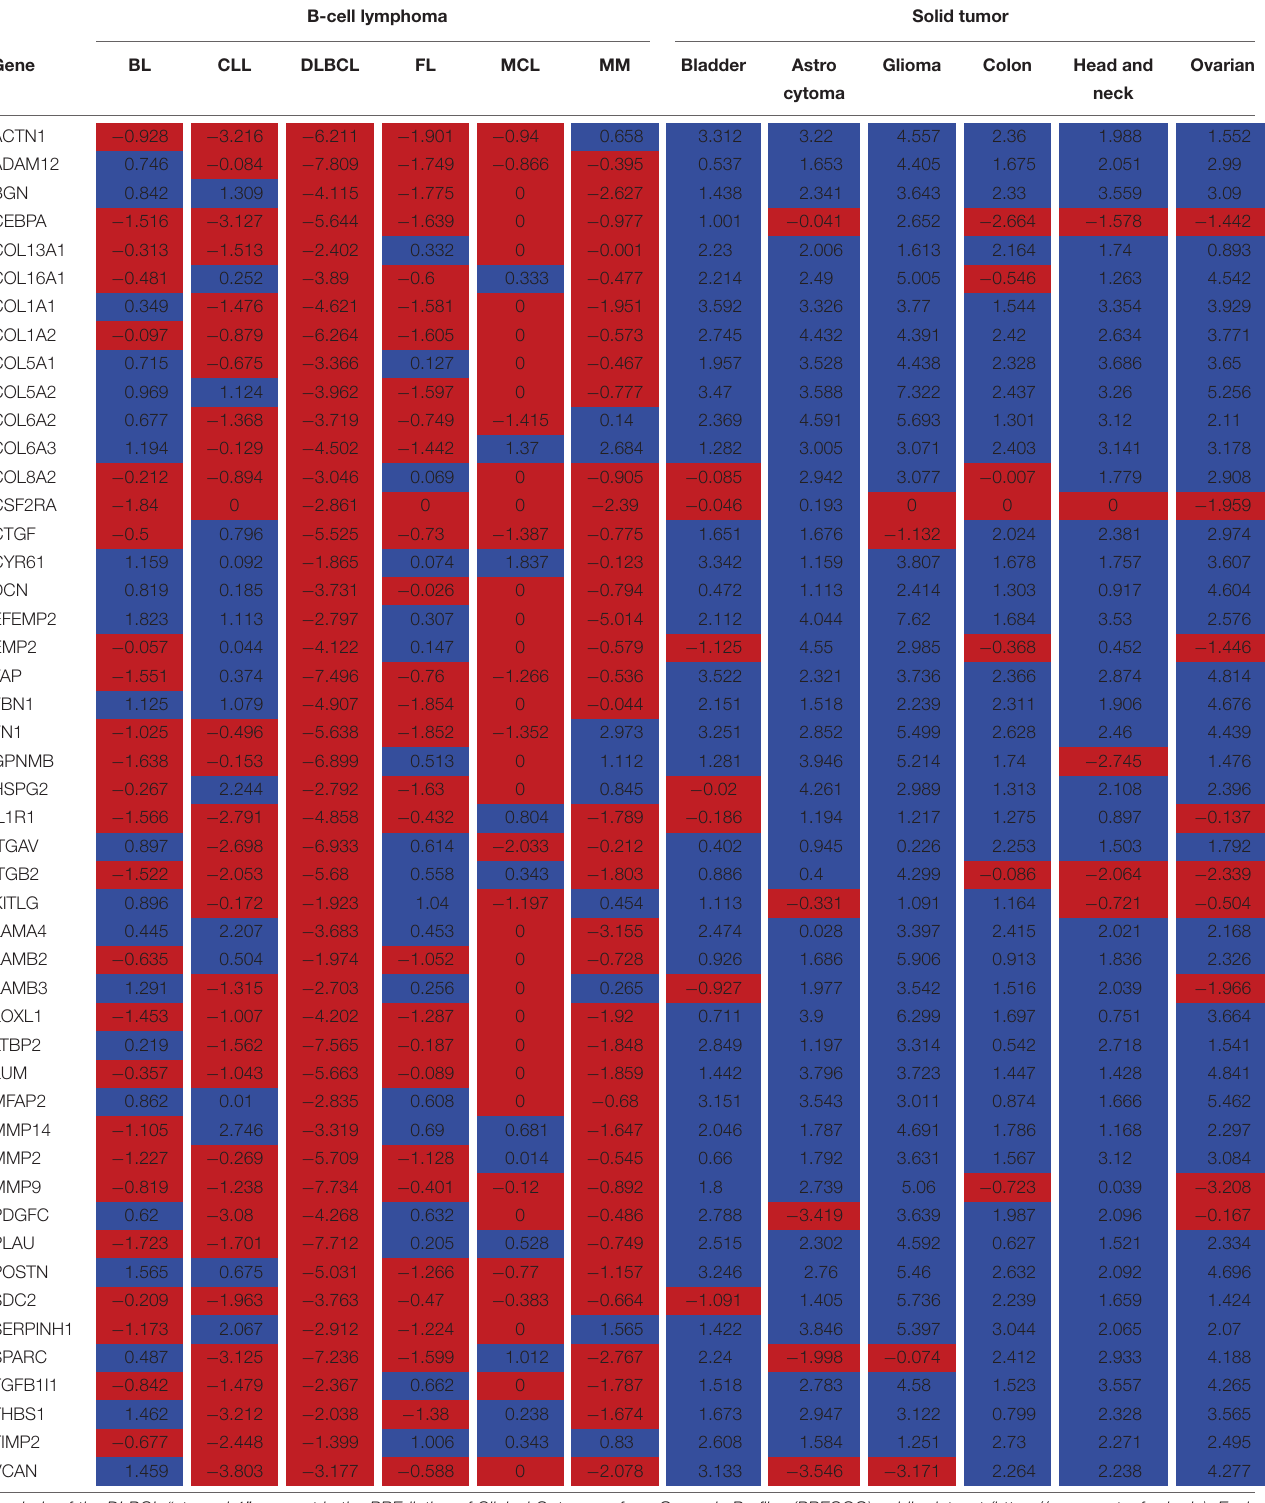
TABLE 1 | DLBCL “stromal-1” signature genes are inversely correlated with survival outcomes in B-cell lymphomas and other malignancies. B-cell lymphoma Solid